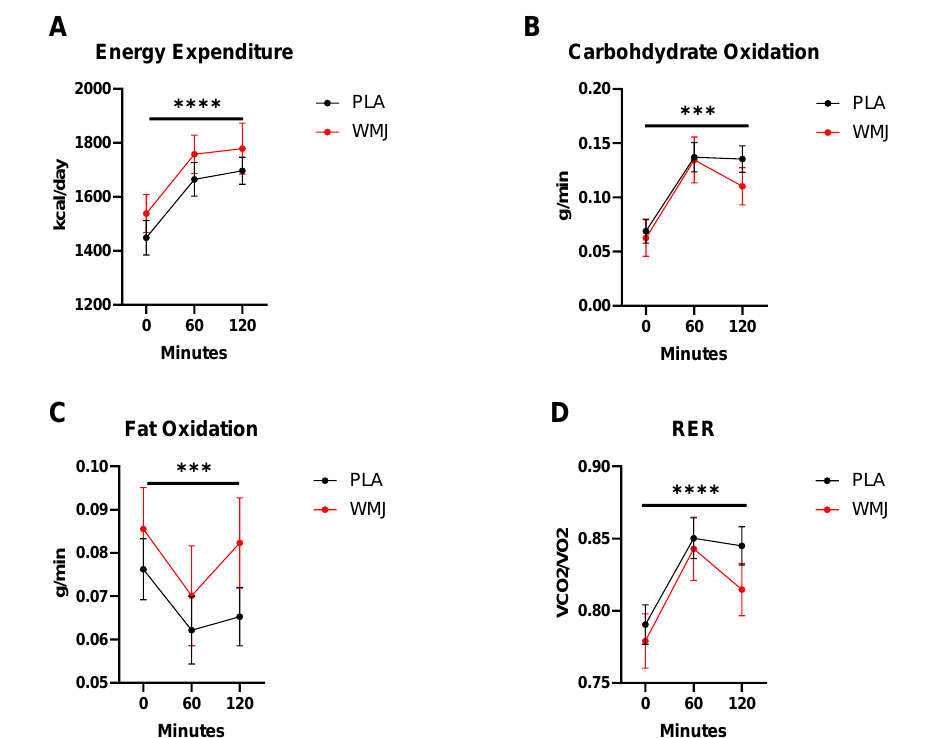
Figure 2. Metabolic responses comparison between PLA versus WMJ treatment during the OGC. ( A ) Energy expenditure, ( B ) carbohydrate oxidation (CHO Ox), ( C ) fat oxidation (Fat Ox), and ( D ) respiratory exchange ratio (RER) all increased significantly during the OGC. No significant treatment effects were detected. Data are means ± SD. (time effects indicated as *** p < 0.001 and **** p < 0.0001.) Table 3 shows Pearson’s correlation coefficients for REE and RER responses ver- Table 3. HRV and metabolic parameter correlations. sus HRV parameters during the OGC. The REE was negatively correlated with pNN50 (r = − 0.24, p = 0.04) and HF (r = − 0.24, p = 0.04) and positively correlated with LF/HF ratio (r = 0.27, p = 0.02). There were no significant treatment effects or interactions for REE and HRV parameters. RER was negatively correlated with SDNN (r = − 0.24, p = 0.04) and TP (r = − 0.25, p = 0.04). There was a significant negative relationship between CHO Ox and RMSSD (r = − 0.27, p = 0.02), SDNN (r = − 0.29, p = 0.01), LF (r = − 0.29, p = 0.01),